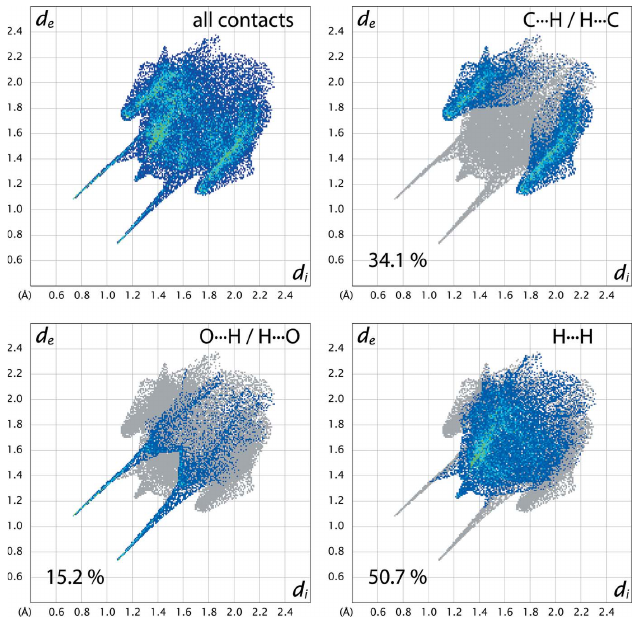
Figure 7 Two-dimensional fingerprint plots showing the distribution of interatomic contacts on the Hirshfeld surface of the phenol molecule in phenol